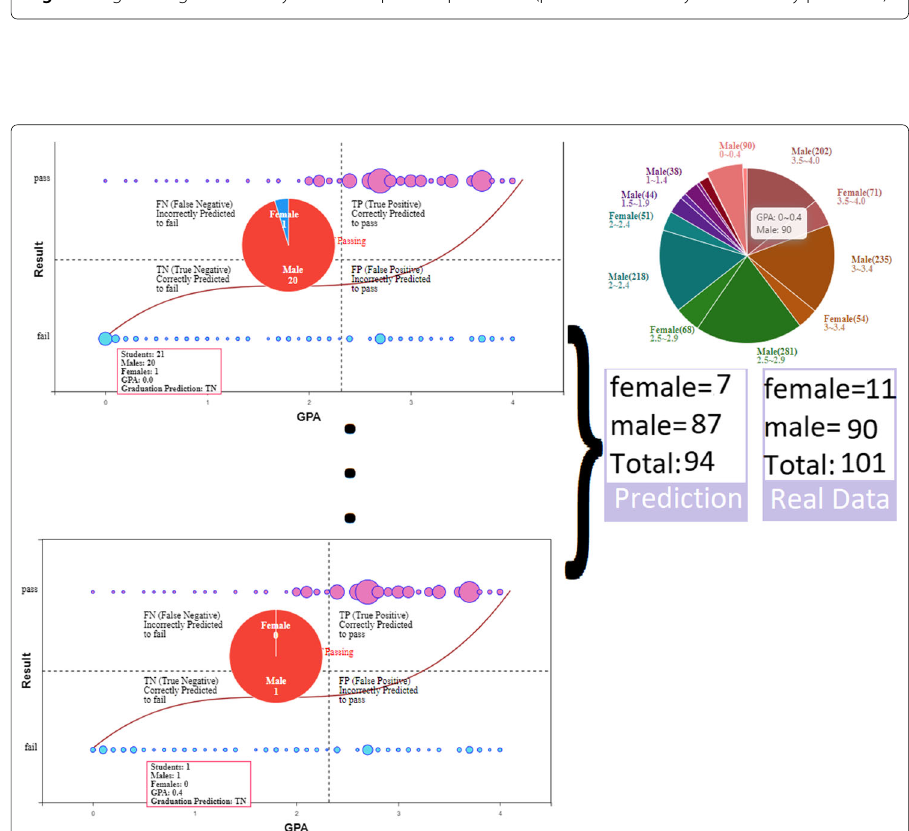
Fig. 27 Logistic Regression analysis for True negative (failed and correctly